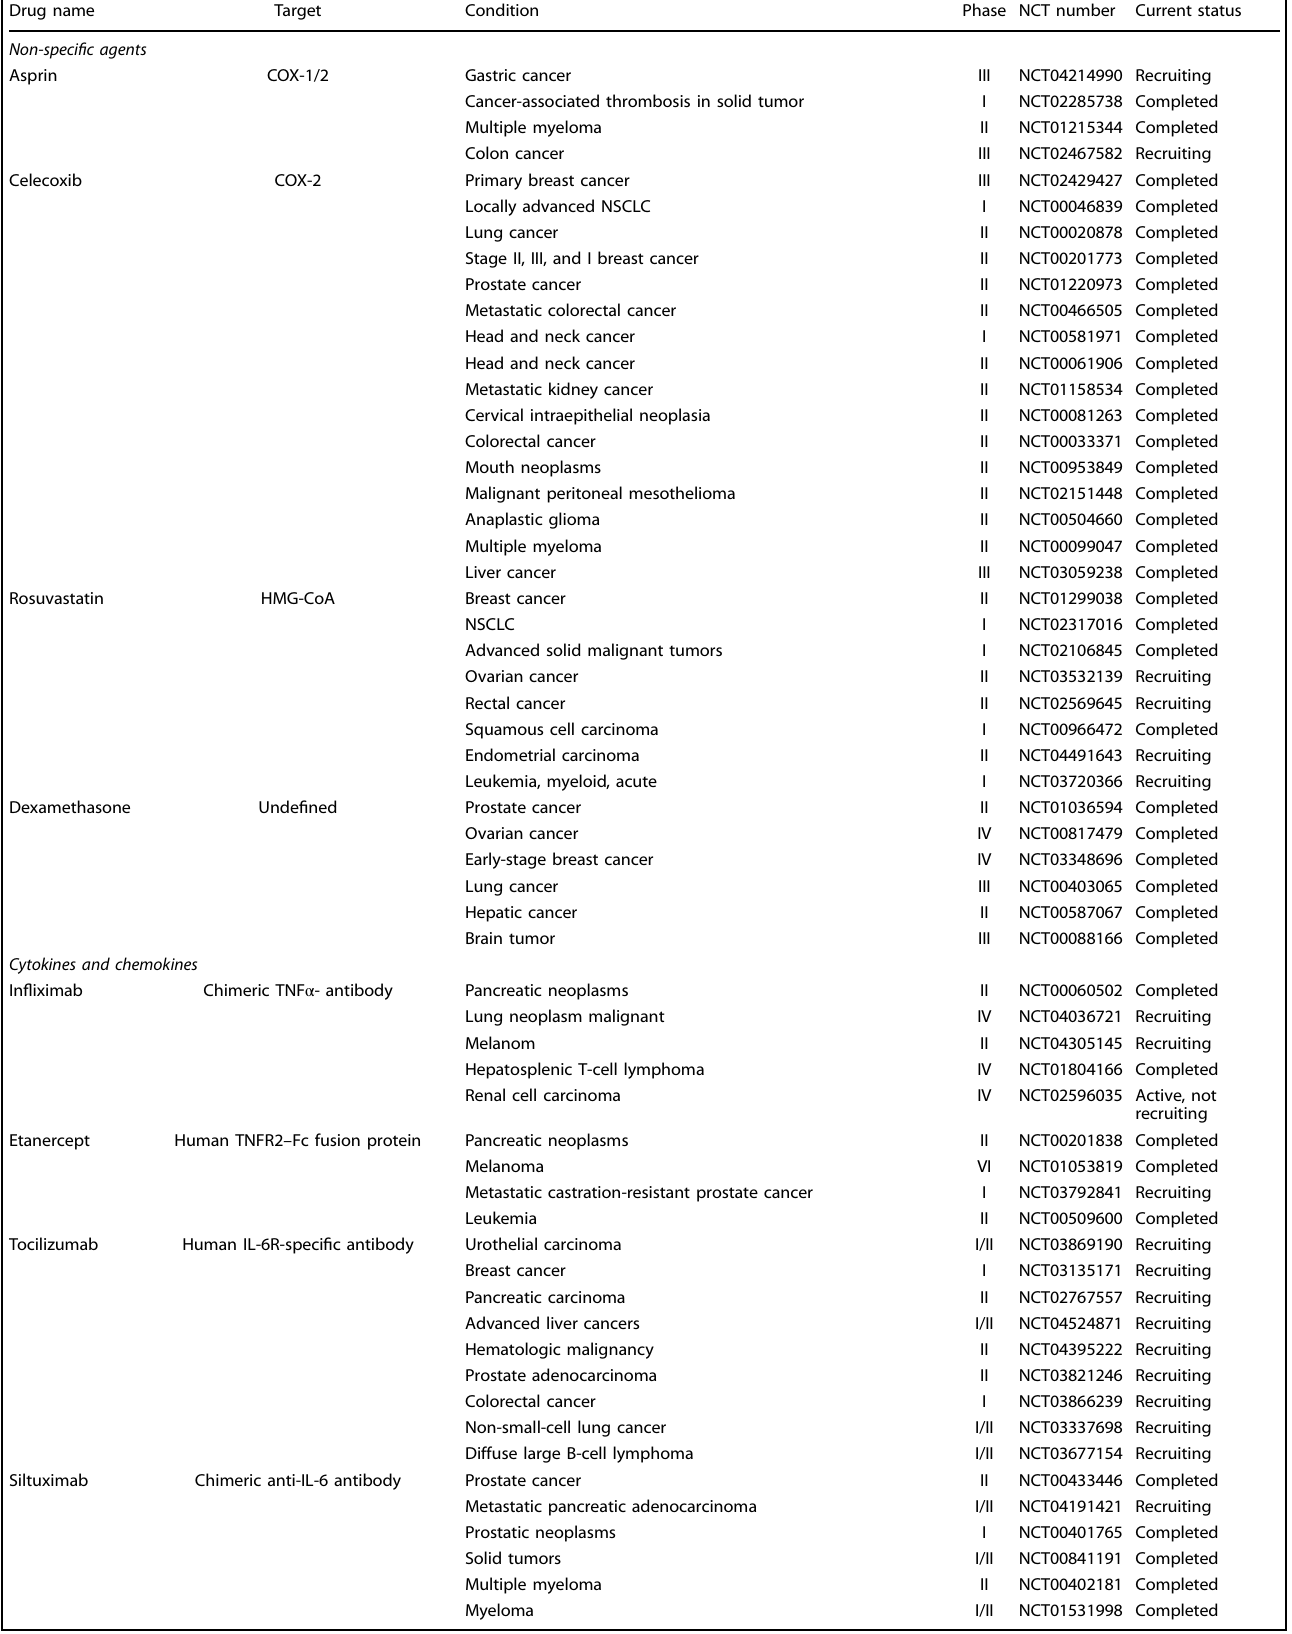
Table 1. Agents targeting cancer-associated in fl ammation signaling pathways in ongoing or completed clinical trials Drug